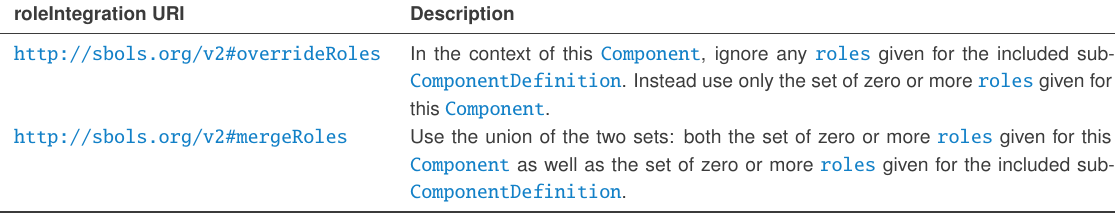
Table 6: Each roleIntegration mode is associated with a rule governing how a Component ’s roles are to be combined with the included sub- ComponentDefinition ’s roles.